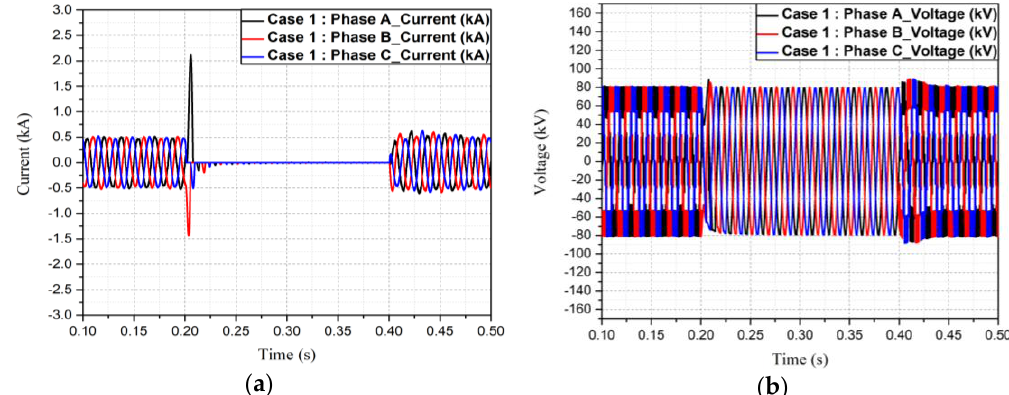
Figure 11. The transient waveforms of the AC system in Case-1: ( a ) current waveform; ( b ) voltage waveform.